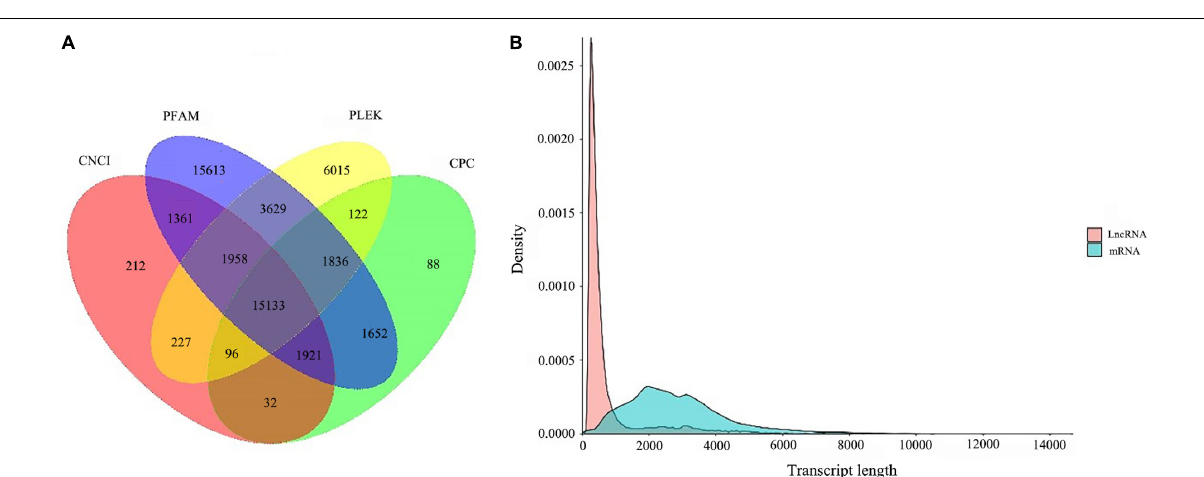
FIGURE 6 | LncRNA analysis. (A) coding potential prediction Venn diagram. The sum of the numbers in each large circle represents the number of Lnc predicted by the coding potential prediction software, and the overlapping part of the circle represents the common number of Lnc between combinations. (B) and the length distribution of LncRNA and